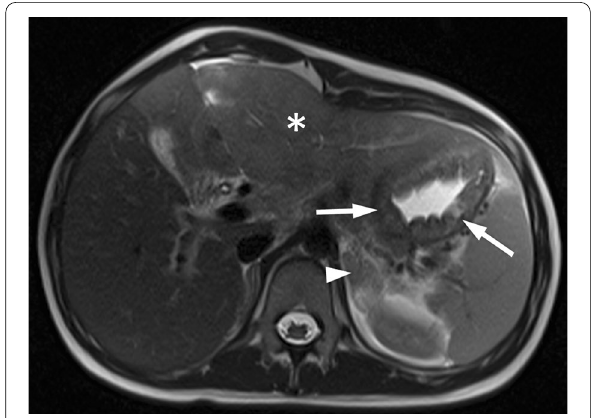
Fig. 11 A 15-year-old girl with gastric adenocarcinoma (signet ring cell carcinoma). She had abdominal pain and anemia complaints for the last 4–5 months. Her Hb value was 6.9 gr/dL (normal range 11.7– 15.5 gr/dL). Axial T2-weighted image shows diffuse increased gastric wall thickening (arrows) and diffuse hyperintense heterogeneous metastases at the left liver lobe (asterisk). Note the left adrenal mass consistent with metastasis (arrow